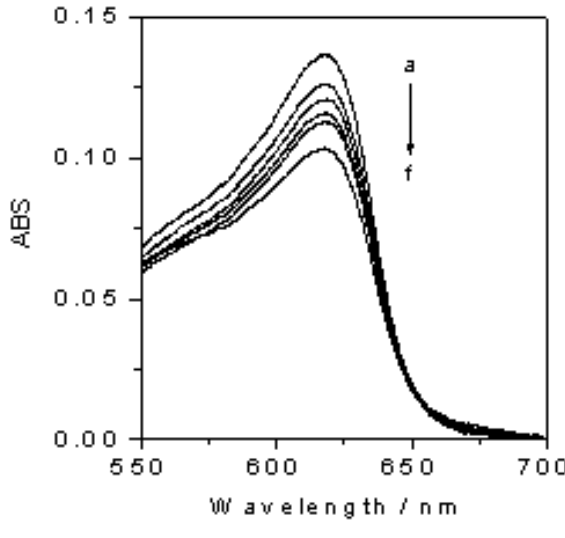
in different dsDNA concentrations of 0, 20, 40, 6